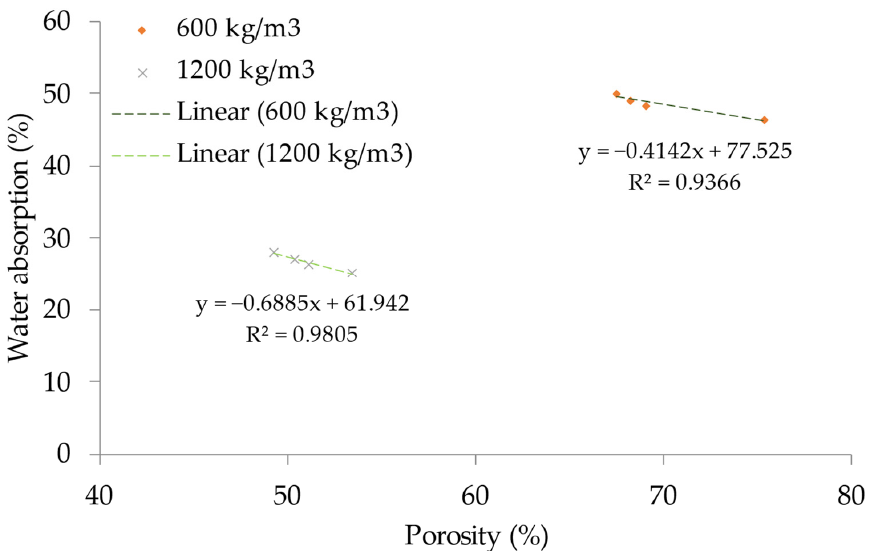
Figure 13. Relationship between water absorption and porosity.